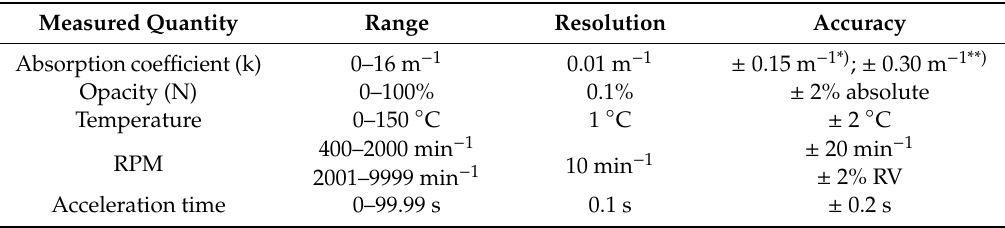
Table 2. Technical specification of Opacimeter Atal AT–605.